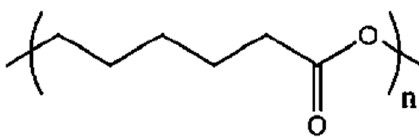
Figure 1. Poly( ε -caprolactone) chemical structure.